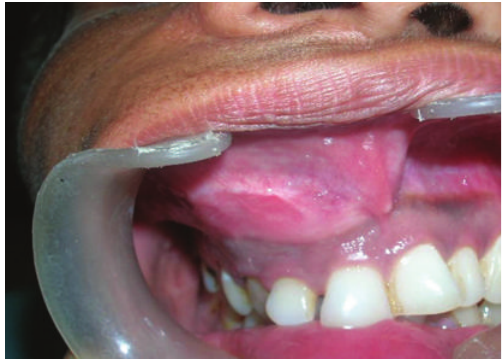
Figure 3: Swelling obliterating buccal vestibule.